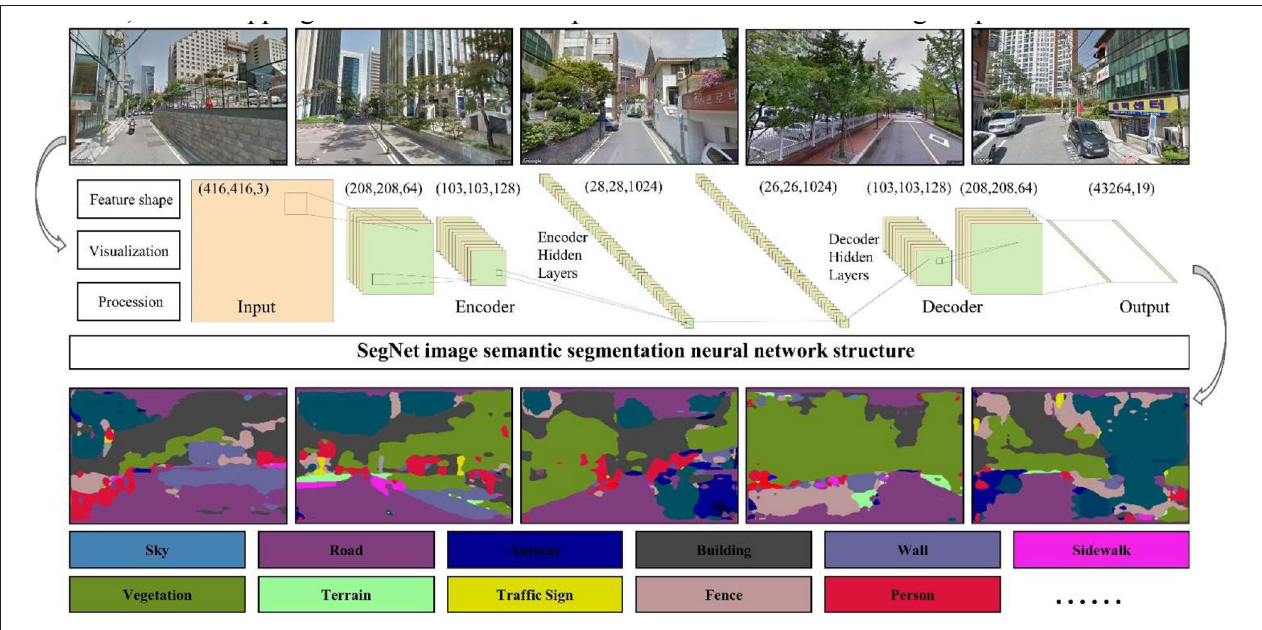
FIGURE 4 | Visual elements extraction from urban street images using the SegNet image semantic segmentation